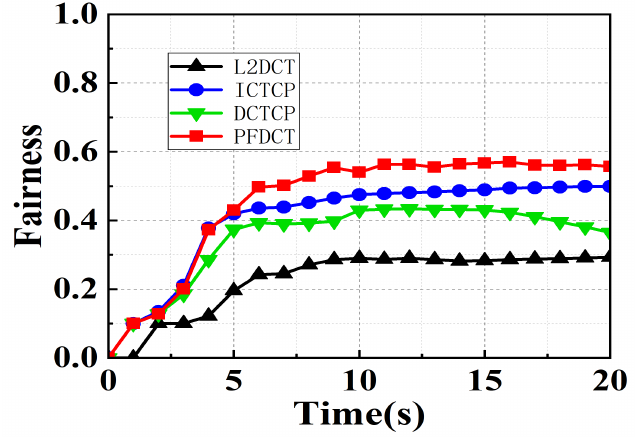
Figure 13. Jain’s fairness index in large-scale